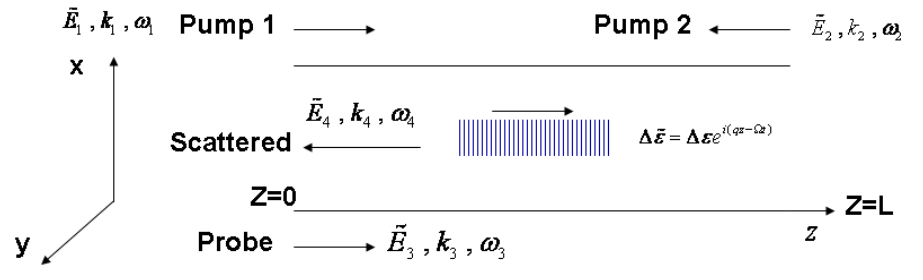
Figure 11. Brillouin grating generation and reading